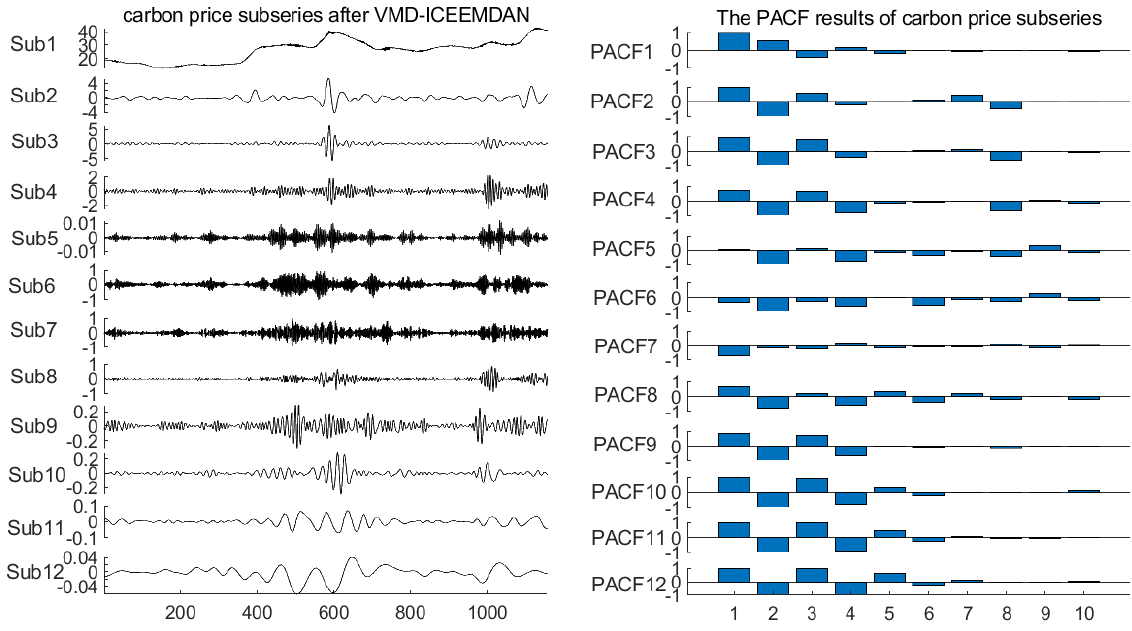
Figure 4. Reconstructed results of the carbon price and the results of their PACF test.